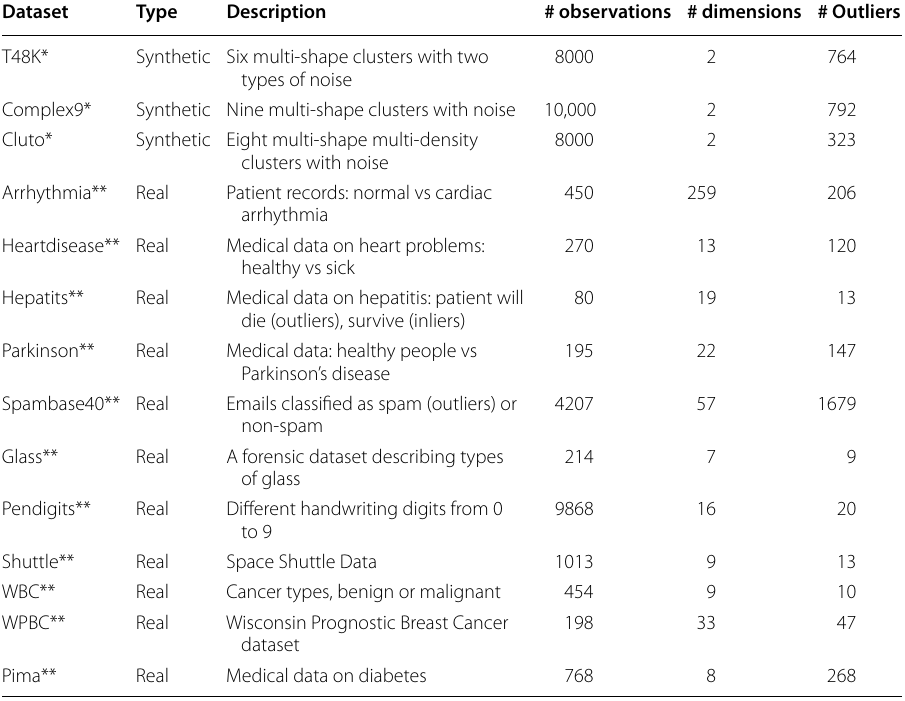
* Available at: https:// github. com/ deric/ clust ering- bench mark ** Available at: https:// www. dbs. ifi. lmu. de/ resea rch/ outli er- evalu ation/ DAMI/ Table 3 ROC AUC comparison using three synthetic datasets